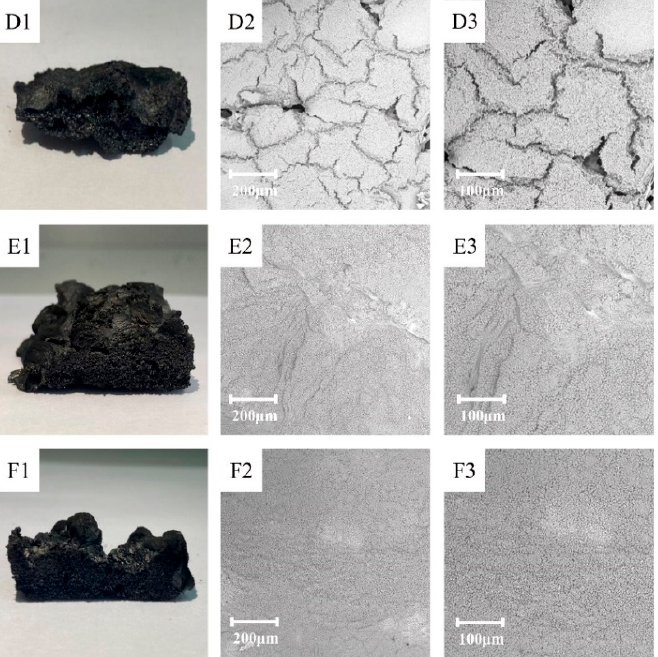
Figure 10. ( D1 , E1 , F1 ) show the morphology of char layers; ( D2 , E2 , F2 ) were taken at × 300 magnification; ( D3 , E3 , F3) were taken at × 500 magnification.